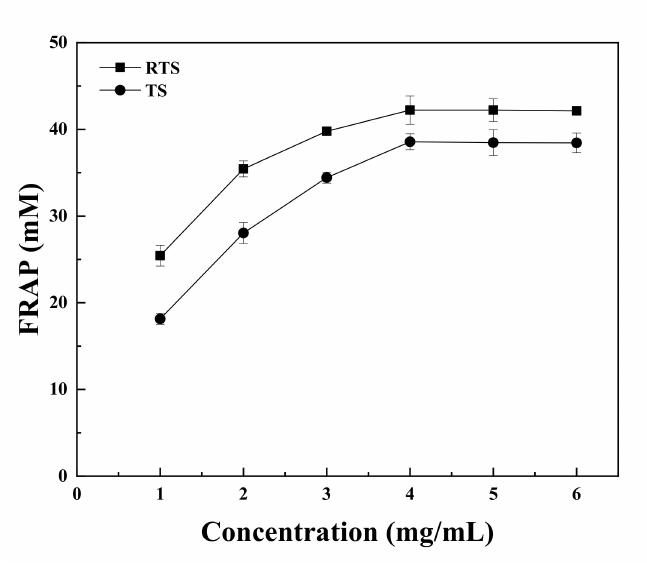
Figure 9. The ferric reducing antioxidant power (FRAP) levels of TS and RTS.